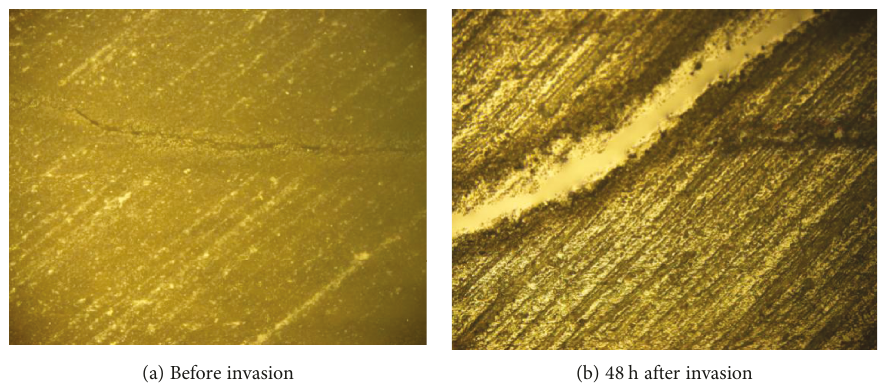
Figure 2: Clear water intrusion along microcracks in shale.